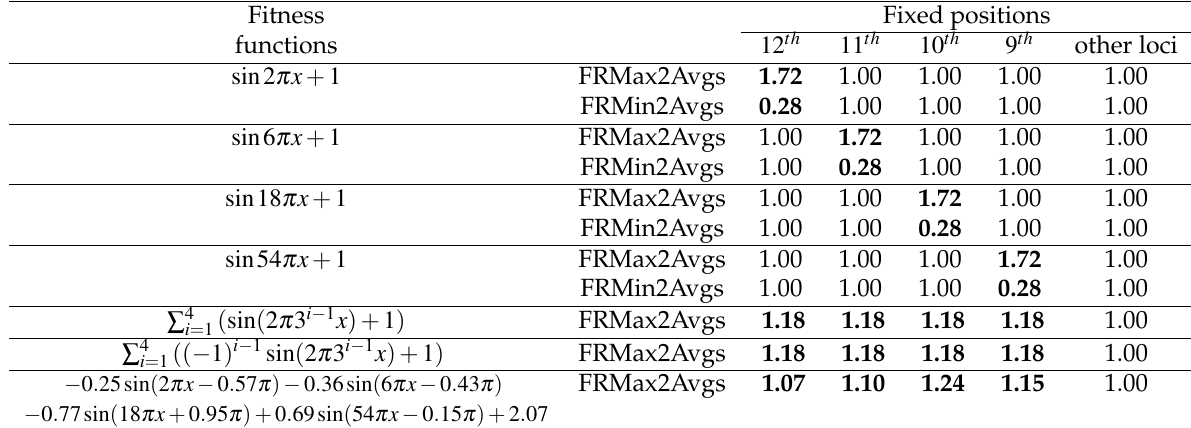
Table 3. The FRMax2Avgs and FRMin2Avgs for sin ( 2 π 3 i − 1 x )+ 1 , i ∈ { 1 , ··· , 4 } and the FR- Max2Avgs for some of their combinations under the base-3 encoding of string length